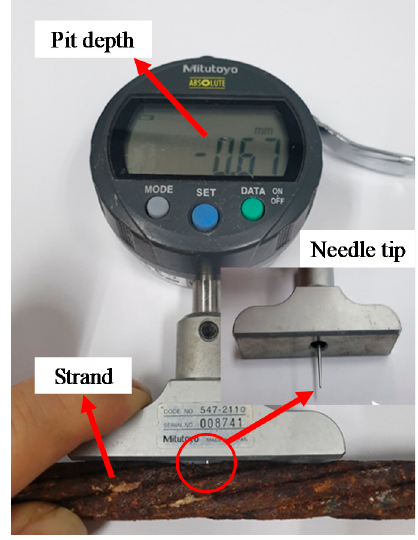
Figure 2. Measuring pit depth of corroded wire.